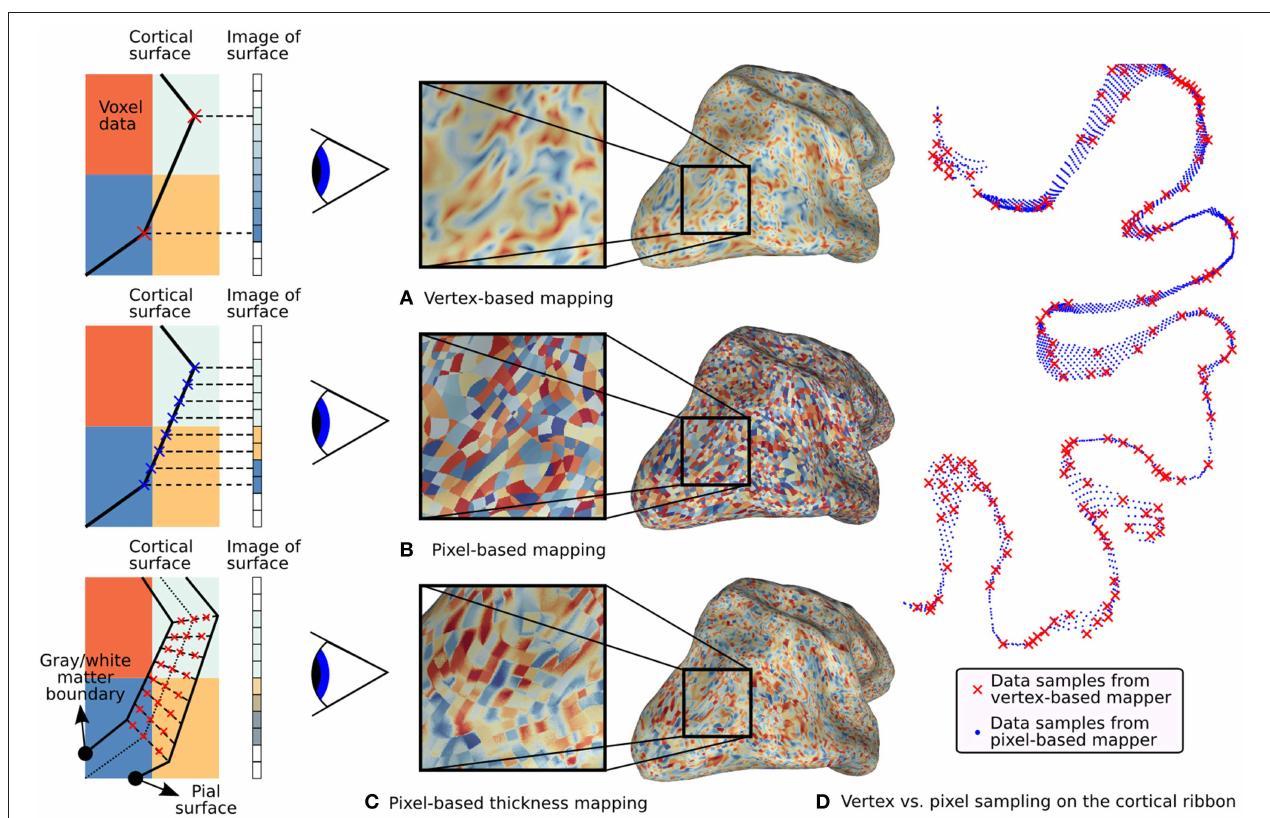
FIGURE 4 | Typical fMRI data projections. On the left, simulated 2D volumes are projected onto a 1D screen. The large colored blocks represent voxel data and the small rectangles represent screen pixels. Three different mapping methods are illustrated along with their effect on the surface. (A) Standard vertex-based mapping uses vertices in the surface mesh to sample the underlying functional data. The vertices (red x’s) sample the functional data using a nearest-neighbor algorithm and the values are automatically interpolated by the rasterizer. Although the surface passes through the orange voxel at bottom right, there are no orange pixels on the screen because there is no enclosed vertex. (B) Pixel-based mapping projects screen pixels into the volume to sample the underlying data. Orange pixels now appear on the screen since the surface passes through that voxel. (C) Thickness mapping samples data along the entire line between the white matter and the pial surface, thereby reflecting activity throughout the thickness of the cortical mantle. (D) The difference in sampling density between pixel-based and vertex-based mapping is shown for a 1mm slice through the cortical volume as it is mapped onto a flat map. Vertex samples are shown as red x’s and pixel samples are shown as blue dots. The increased density improves the accuracy of functional data display, particularly with high-resolution functional